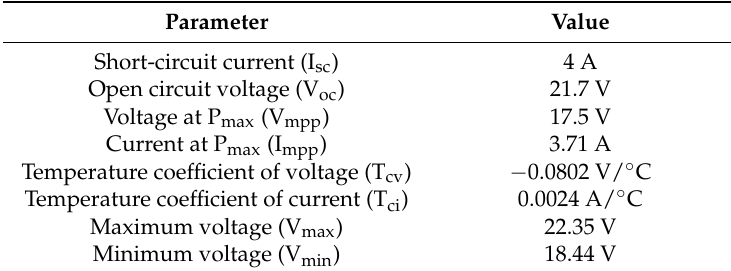
Table 1. Electrical parameters of the PV module type